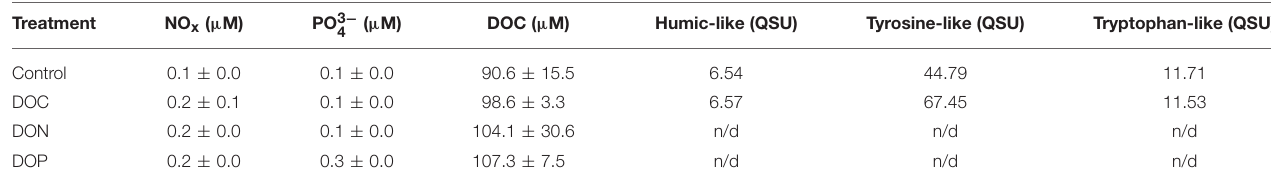
TABLE 4 | NO x , PO 3 − 4 , DOC concentrations and values of FDOM-related ratios for the different DOM additions (DOC, DON, and DOP treatments) performed at Station 2.